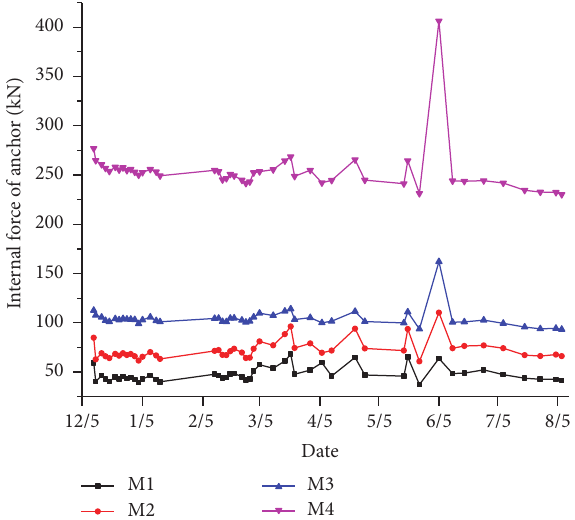
Figure 15: Anchor internal force with time variation curve.